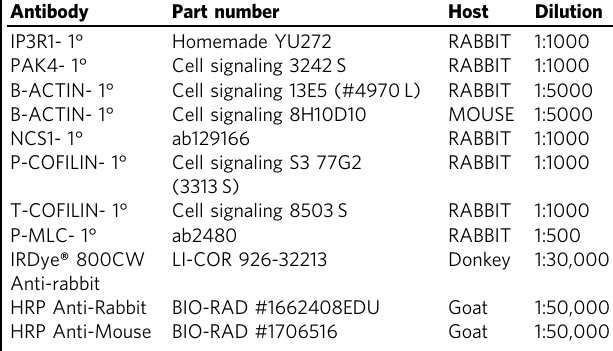
Table 2 Antibody